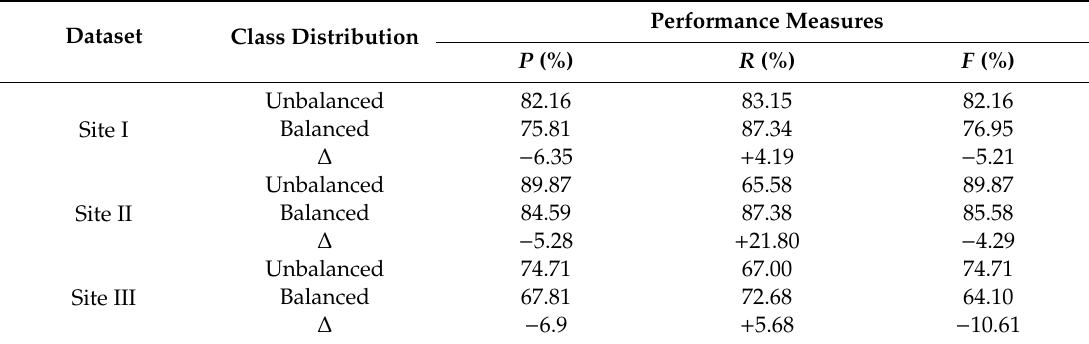
Table 10. Classification performance for di ff erent class distributions (classifier = RF, feature set = F 0 , R = 1.5 m). Three performance measures are shown in the table. The symbol ∆ denotes the di ff erence between the measures obtained by balanced and unbalanced learning. P denotes macro precision, R denotes macro recall, and F denotes the macro F1.